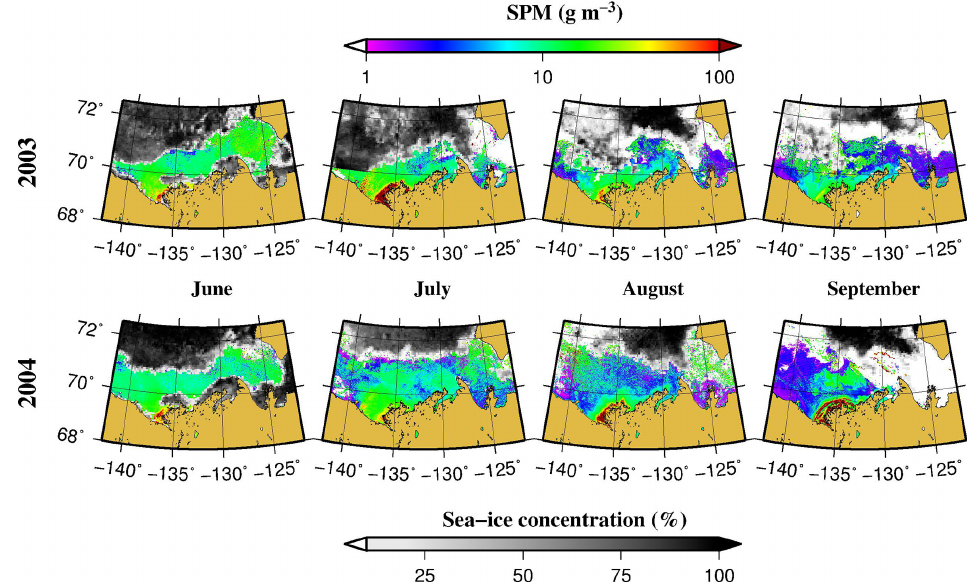
Figure 6. Monthly (June to September) composites of sea-ice and surface water SPM concentrations in 2003 and 2004.